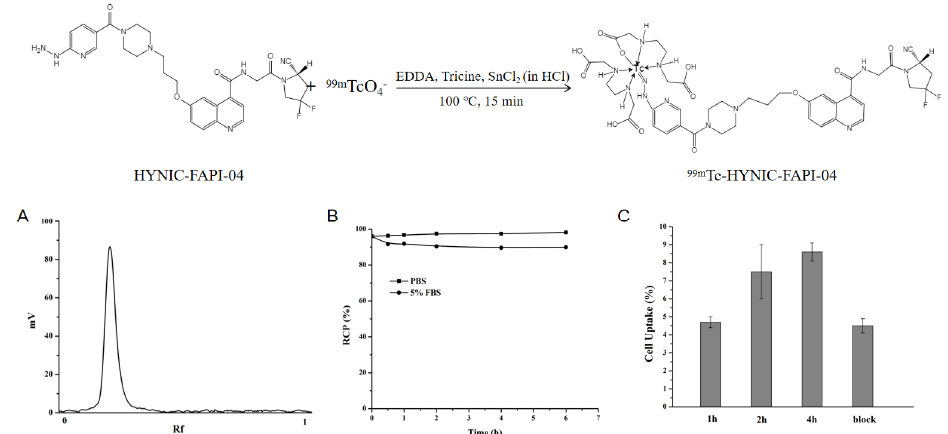
Figure 1. Schematic preparation of 99m Tc-HYNIC-FAPI-04, and the in vitro characteristics, including ( A ) the labeling rate, ( B ) time-dependent stability in PBS and 5% FBS, and ( C ) U87MG-specific cellular binding efficiency (EDDA: ethylenediamine diacetic acid, PBS: phosphate buffer solution, FBS: fetal bovine serum).